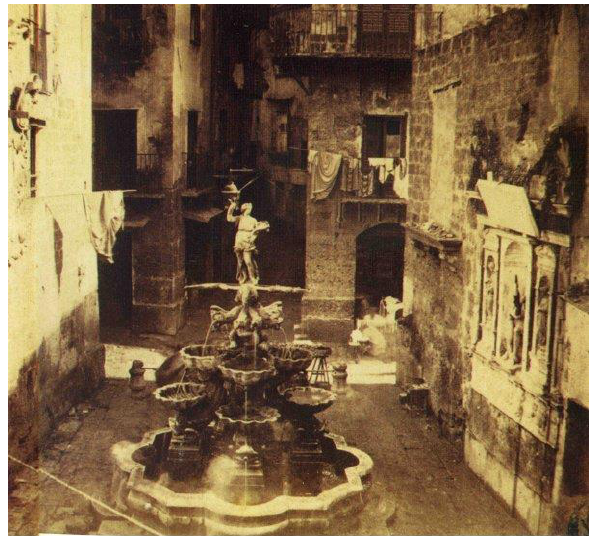
Figure 2. The Garraffo fountain in its original placement in Piazza Garraffo before the year 1862.